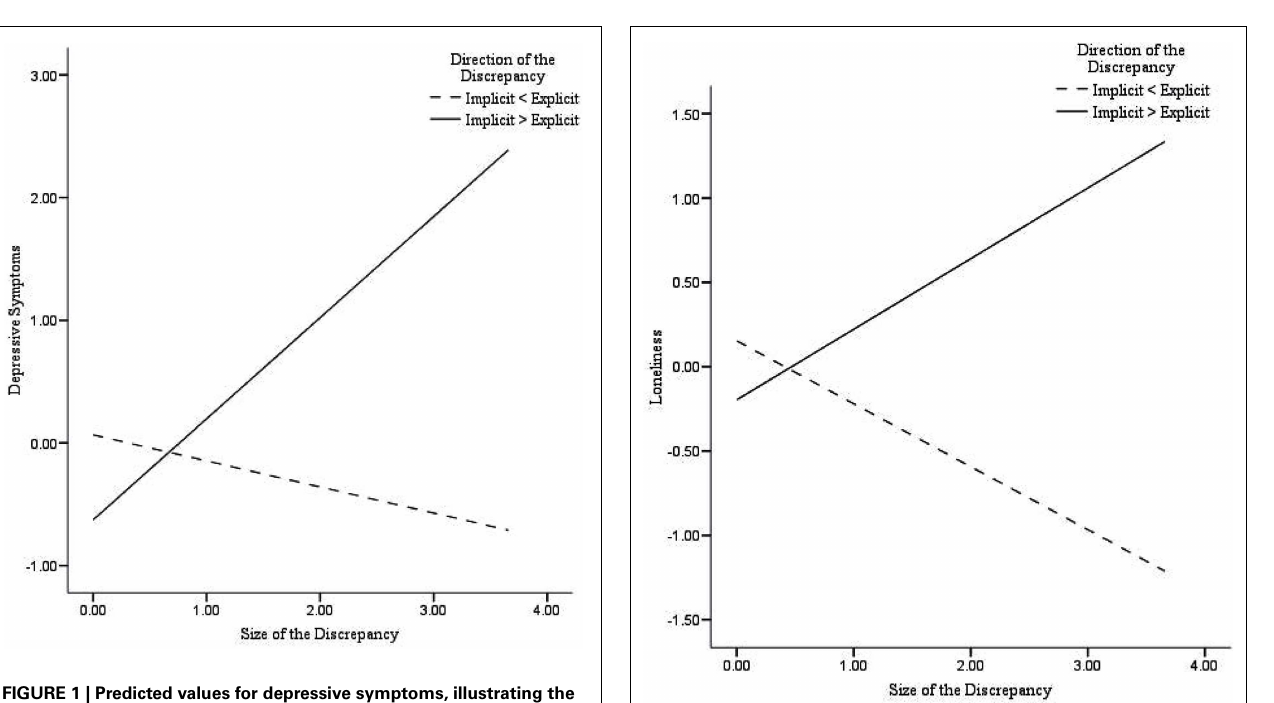
FIGURE 1 | Predicted values for depressive symptoms, illustrating the interaction between the size of the discrepancy and the direction of the discrepancy.